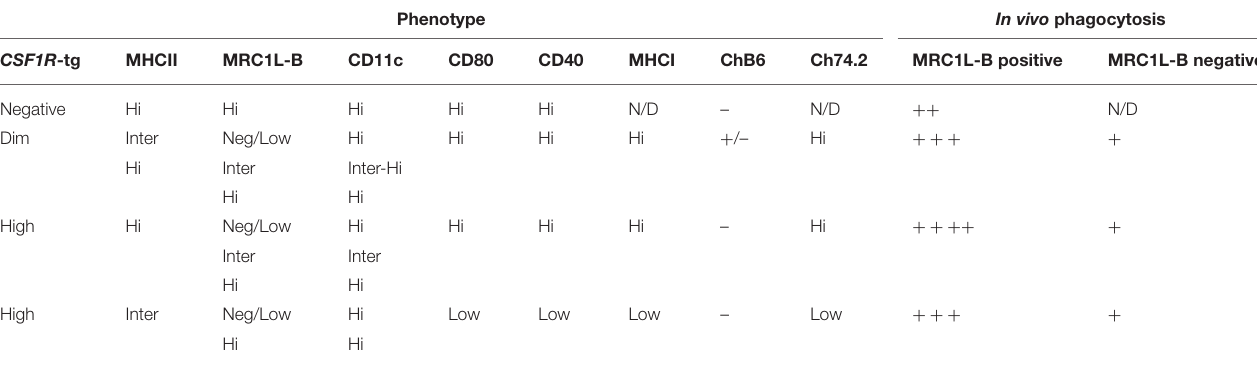
TABLE 2 | An overview of the phenotype and phagocytosis abilities of MPS in the chicken spleen as determined by immunohistology and flow cytometry.